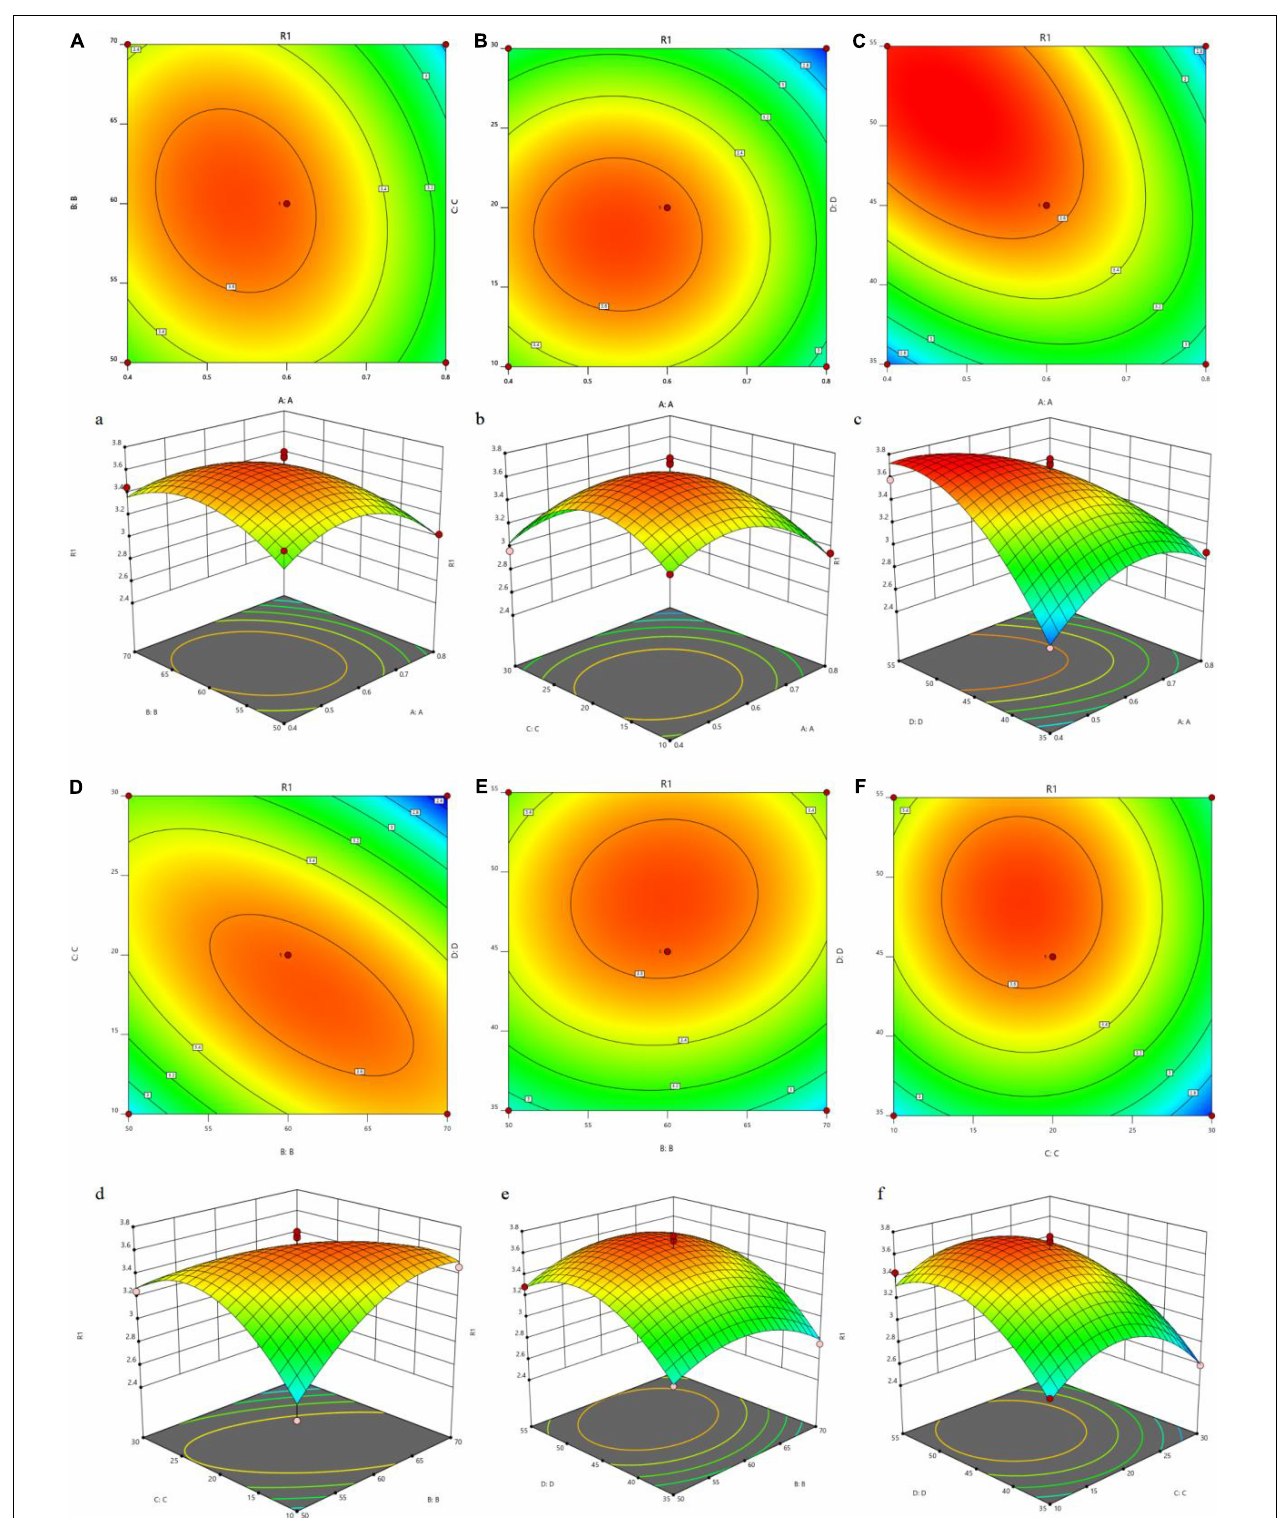
FIGURE 1 | Tri-dimensional response surface plots and contour plots illustrating the interaction between the different variables on the yield of JCH. ( (a,A) enzymatic addition and ultrasonic temperature; (b,B) enzymatic addition and ultrasound time; (c,C) enzymatic addition and liquid-solid ratio; (d,D) ultrasonic temperature and ultrasonic time; (e,E) ultrasonic temperature and liquid-solid ratio; (f,F) ultrasonic time and liquid-solid ratio; R1, JCH yield).